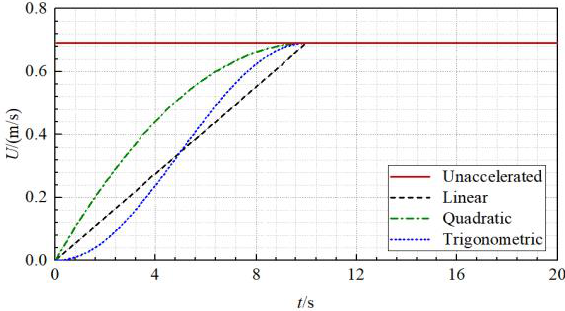
Figure 6. Time histories of passing speed in the numerical simulations.